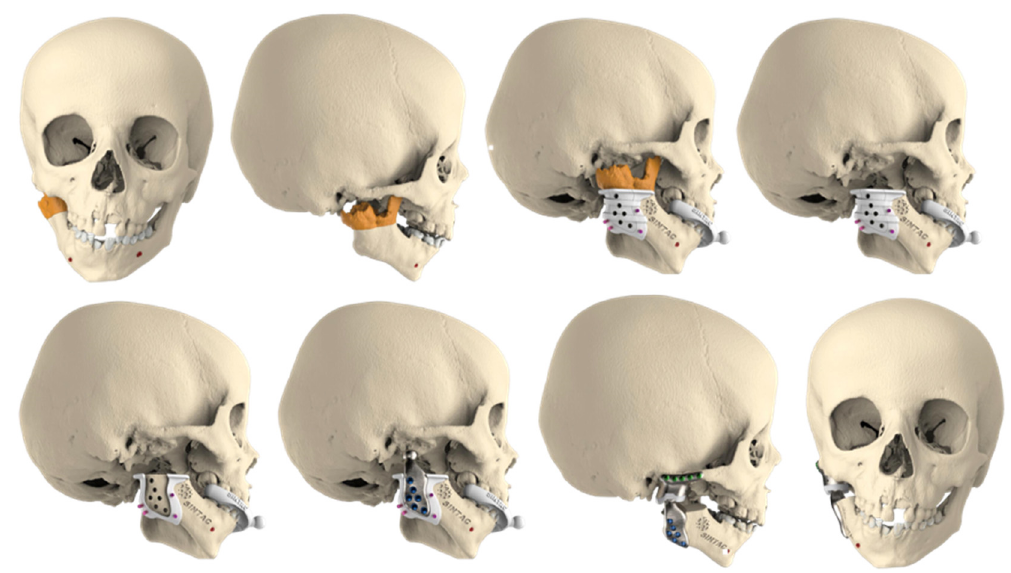
Figure 5. Virtual surgical planning. The mandible was isolated to define the resection plane and subsequently design specific cutting guides and the custom-made prosthesis.